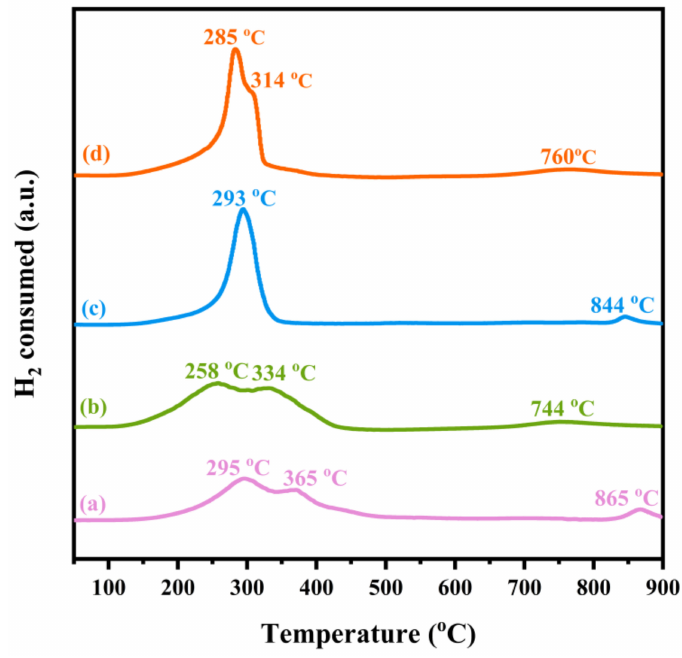
Figure 5. H 2 -TPR profiles of (a) CeMnO x , (b) CeMnO x /diatomite, (c) Pt/CeMnO x , and (d) Pt/CeMnO x